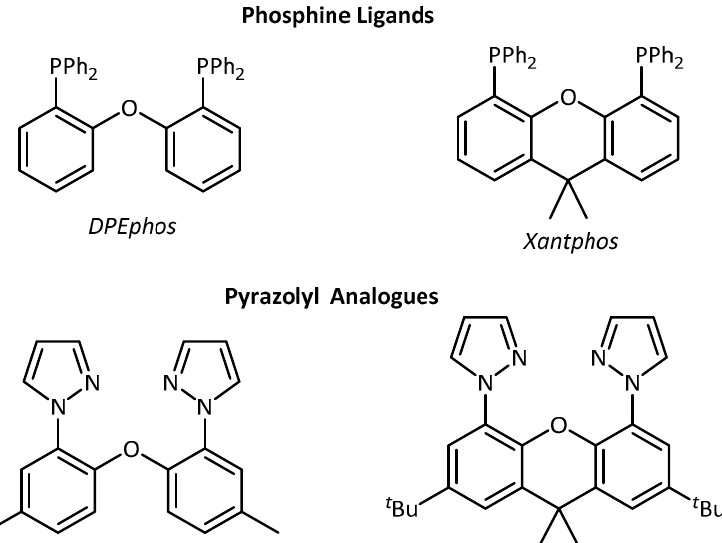
Figure 1. Pyrazolyl analogues of bis[(2-diphenylphosphino)phenyl] ether (DPEPhos) and (4,5-bis(diphenylphosphino)-9,9-dimethylxanthene (Xantphos).